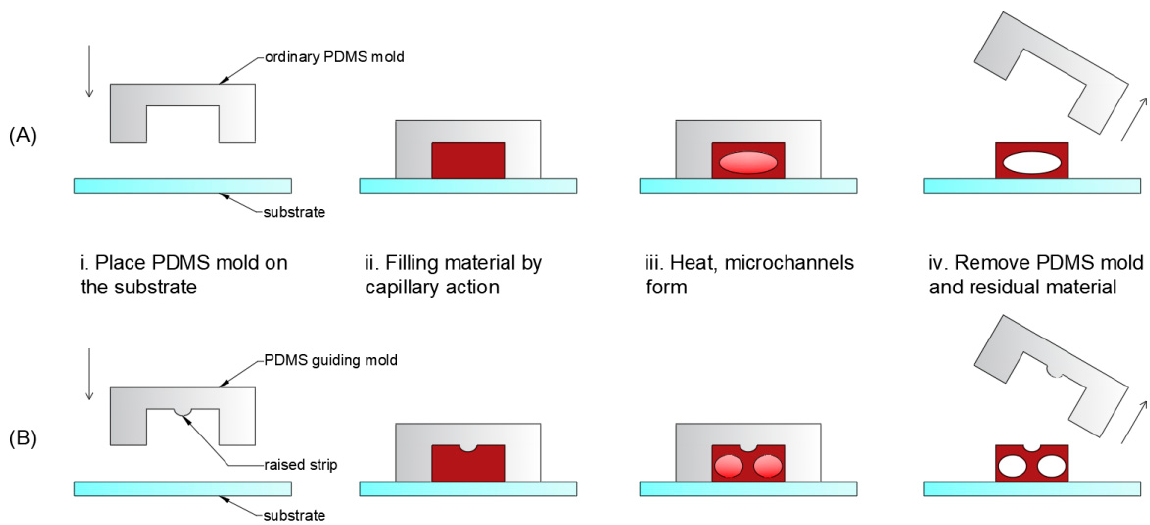
Figure 1. Schematic of fabrication process of the single microchannel ( A ) and the parallel double-microchannels ( B ) in a single microgroove, which consists of four main steps: ( i ) Place PDMS mold on the substrate; ( ii ) Filling material by capillary action; ( iii ) Heat, microchannels form; ( iv ) Remove PDMS mold and the residual material.